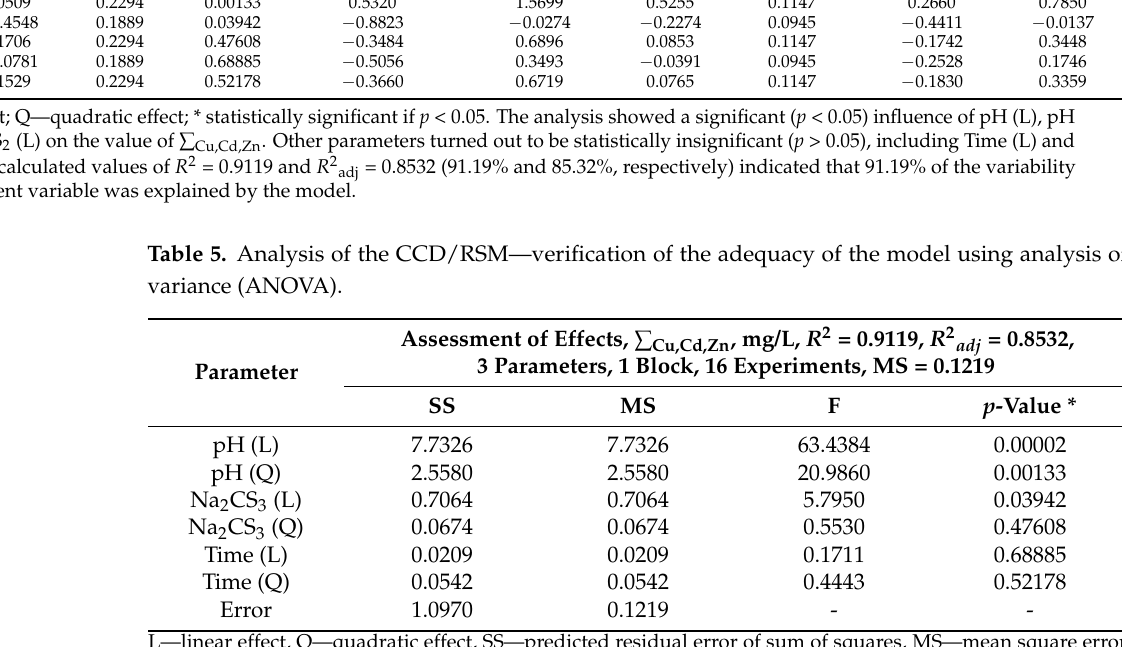
L—linear effect, Q—quadratic effect, SS—predicted residual error of sum of squares, MS—mean square error, F—statistics and * statistically significant if p < 0.05.